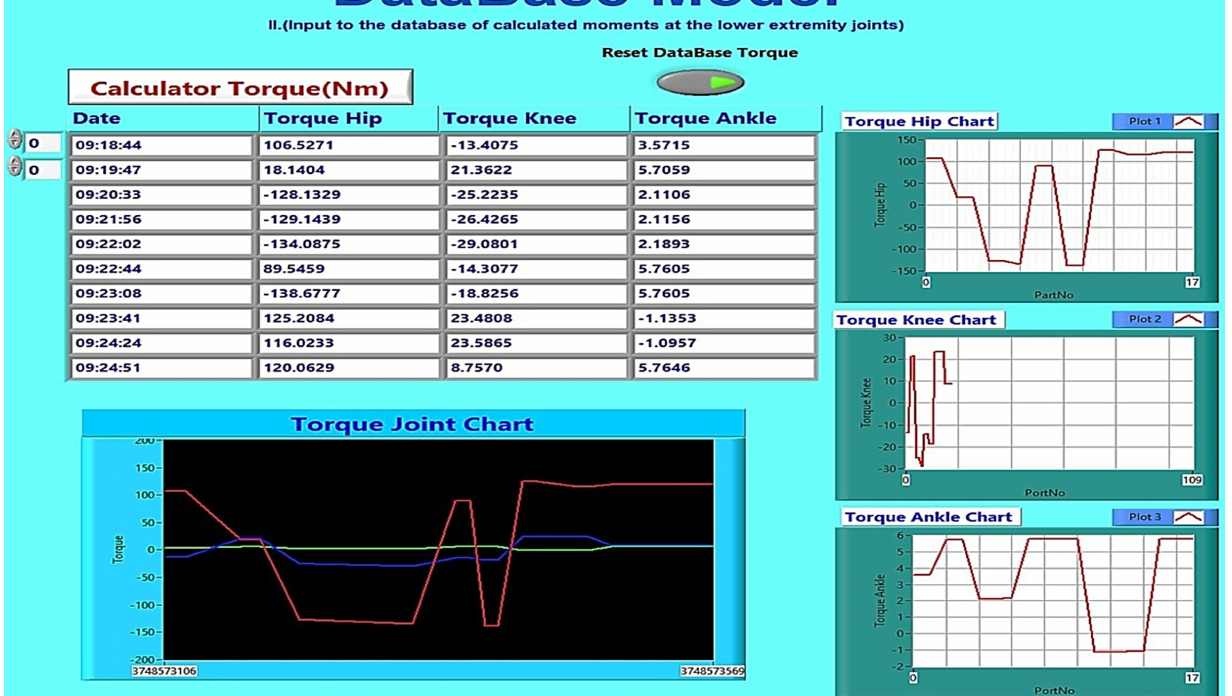
Figure 11. Joint torque calculations and SQL database storage